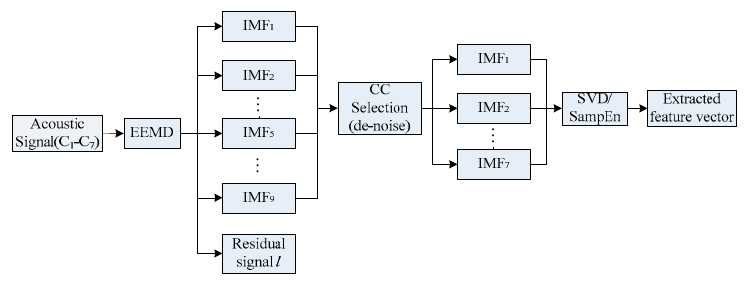
Figure 6. Procedures for performing feature extraction. Energies 2017 , 10 , 1652